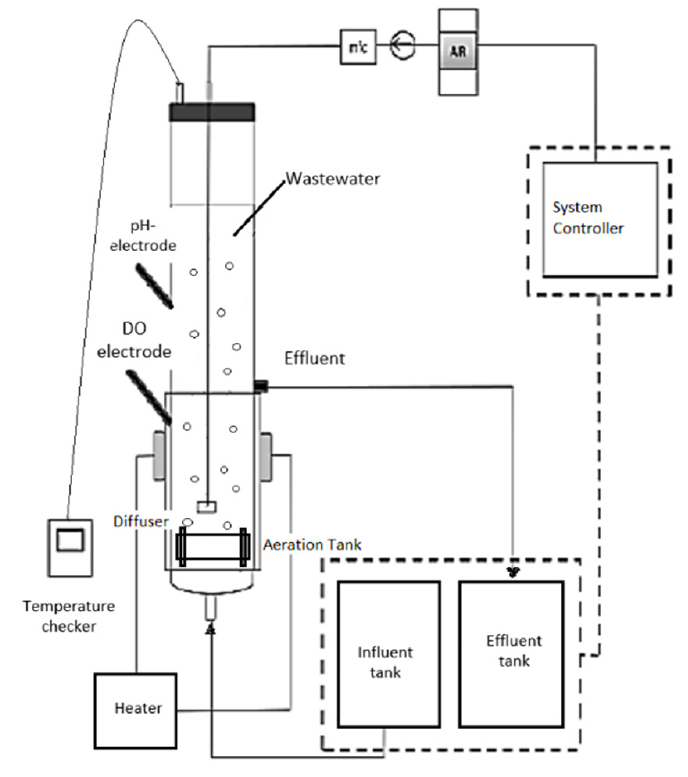
Figure 1. The process of wastewater treatment.